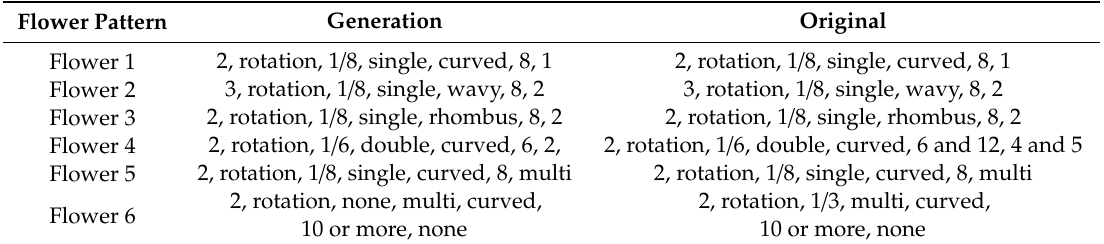
Figure 15. Batik flower patterns. Table 2. Basic features of generated patterns and original patterns.